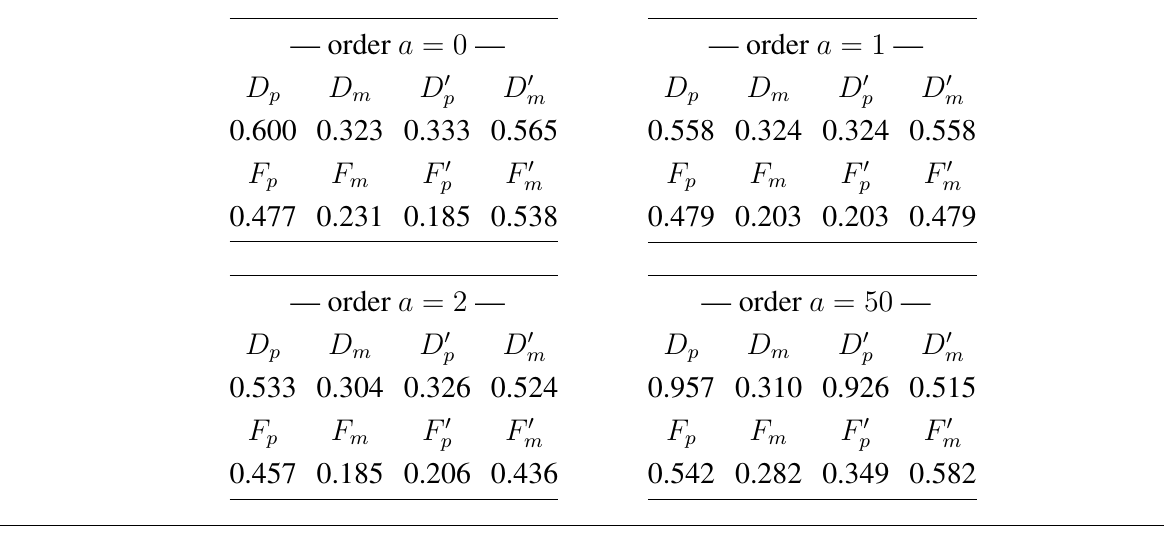
Table 2. Measures of diversity, differentiation and fixation as well as effective numbers that result from application of R´enyi-diversities R provided in Figure